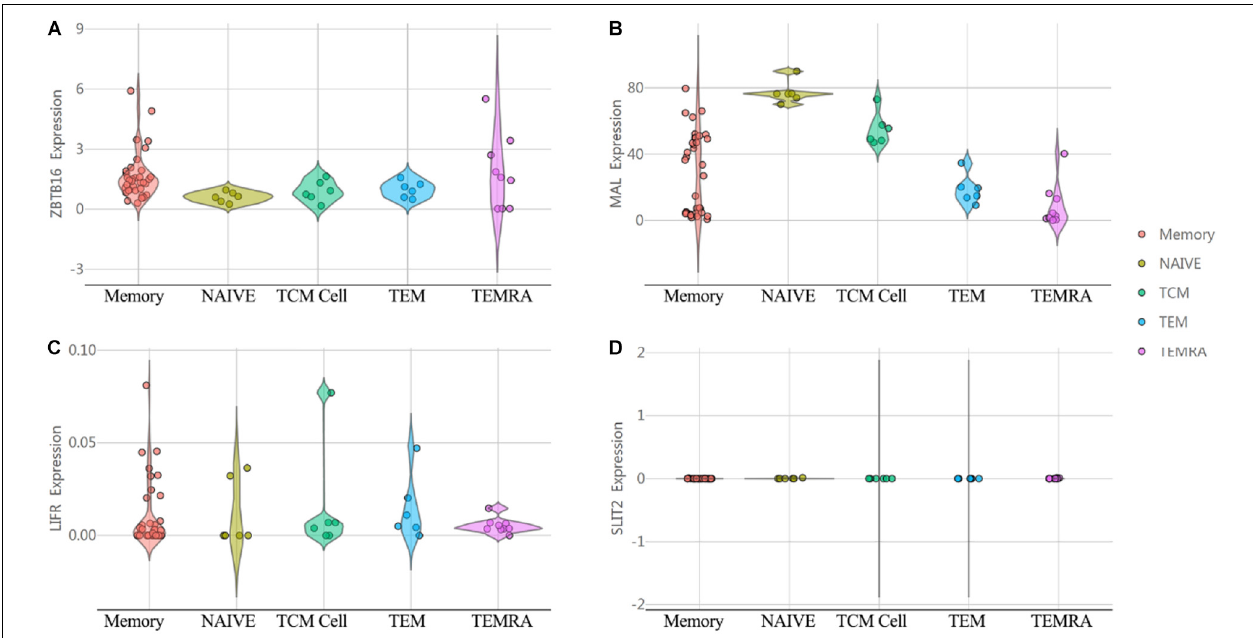
FIGURE 14 | The expression of tumor suppressor genes in the human immune system. (A) ZBTB16. (B) MAL. (C) LIFR. (D)